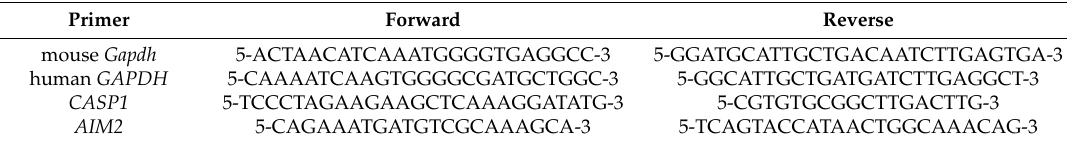
Table 2. Primer sequences for real time